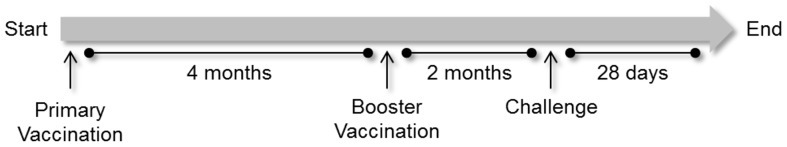
Flow chart showing the experimental setup of vaccination and re-vaccination.All vaccinated groups received a primary vaccination at the start of the experiment. The booster vaccinated groups received a re-vaccination four month post the primary vaccination. All groups were bath challenged with Y. ruckeri O1 BT1 six months post primary vaccination and the mortality in the groups were monitored during four weeks.